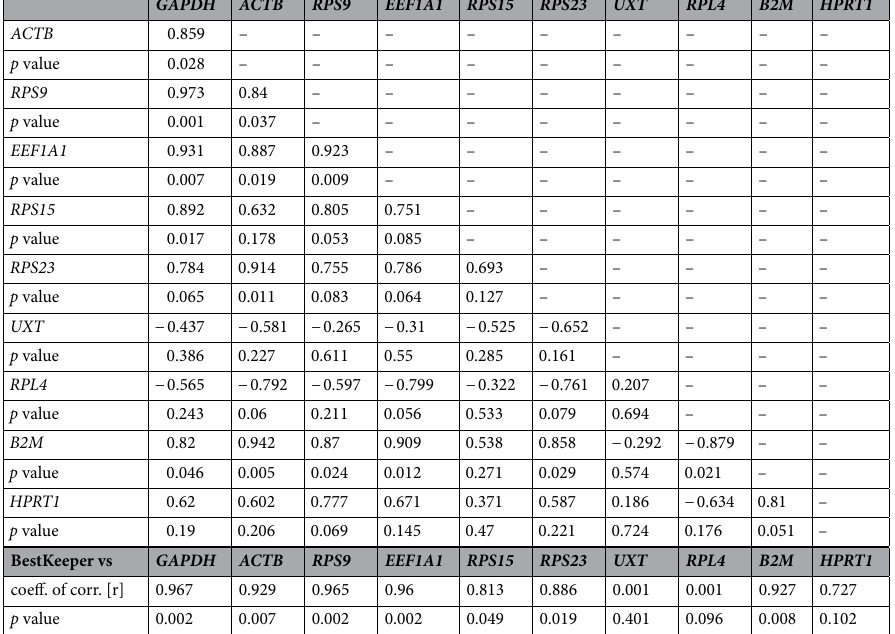
Table 7. Analysis of repeated pair-wise correlation amongst genes in LAY with BestKeeper index.